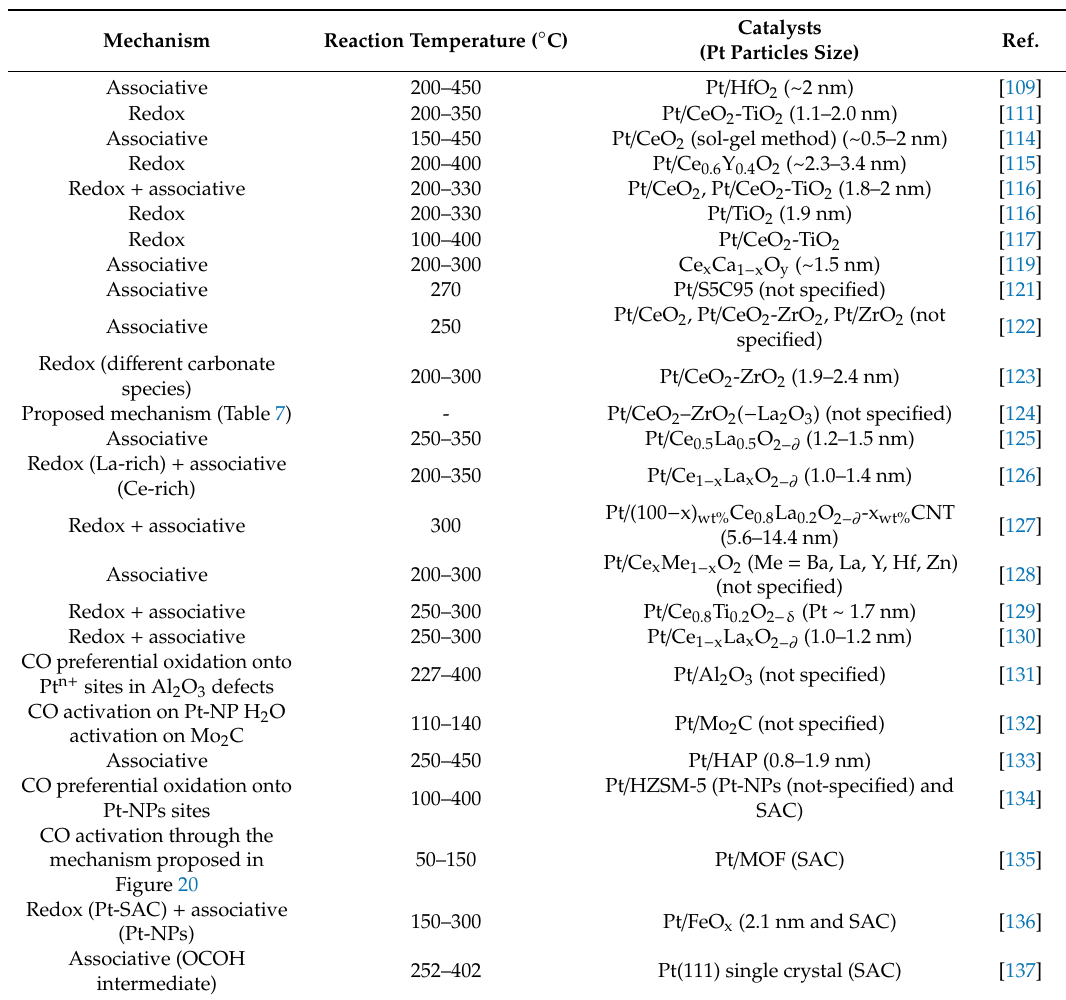
Table 8. Summary of the mechanism reported in Section 4.1: Monometallic Catalysts Supported on Single and Mixed